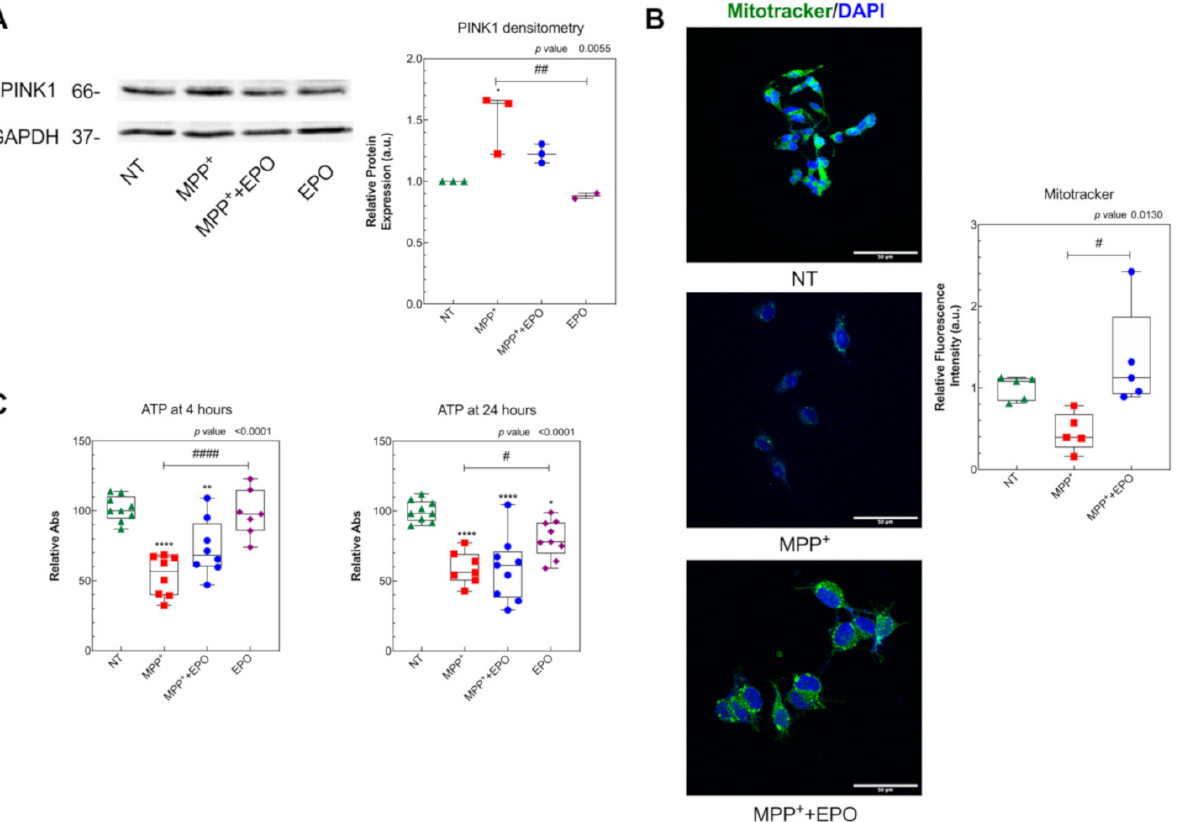
Figure 4. EPO counteracts MPP + -induced mitochondrial dysfunction: ( A ) PINK1 protein expression was evaluated by Western blot in SH-SY5Y cells, after 24 h of treatment with MPP + or MPP + +EPO. Band intensity analysis and the relative protein expression were performed with the software Image-J (NIH). Data are presented in the form of a box-and-whisker plot of 2 independent experiments and results are represented as percent of NT. GAPDH was used as loading control. * p < 0.05 vs. NT; ## p < 0.01 vs. MPP + . ( B ) MitoTracker staining in SH-SY5Y cells, after 24 h of treatment with MPP + or MPP + +EPO. MitoTracker was analyzed with immunofluorescence. Fluorescence quantification, represented in the histogram, was performed with the software Image-J (NIH). Scale bar: 50 µ m. The reported data are presented in the form of a box-and-whisker plot of 3 replicate values in 2 independent experiments ( n = 6) and results are represented as percent of NT. Results are reported as intensity of PINK1 vs. GAPDH, in relation to NT. # p < 0.05 vs. MPP + . ( C ) ATP concentration 4 h and 24 h after treatments. Data refer to 4 independent experiments and results are shown as percent of NT. * p < 0.05, ** p < 0.01, **** p < 0.0001 vs. NT, # p < 0.05, #### p < 0.0001 vs. MPP +